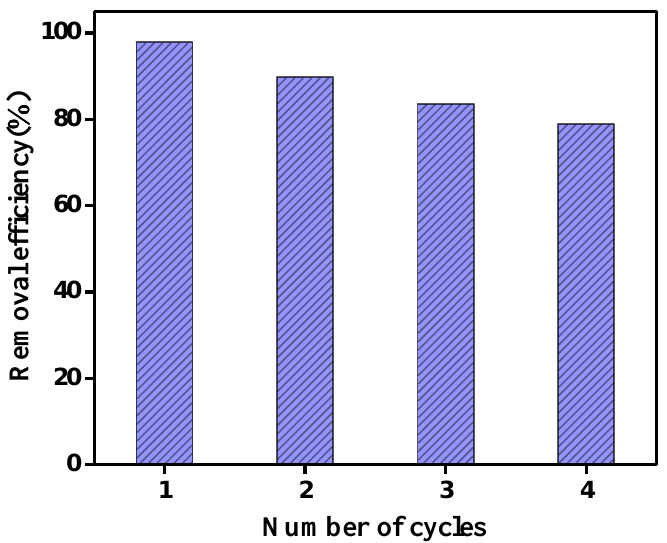
Figure 9. The recycling test of the prepared nanocomposite. Reaction condition: initial BPA concentration of 10 mg/L, PMS dosage of 1 mmol/L, catalyst addition of 1 g/L.